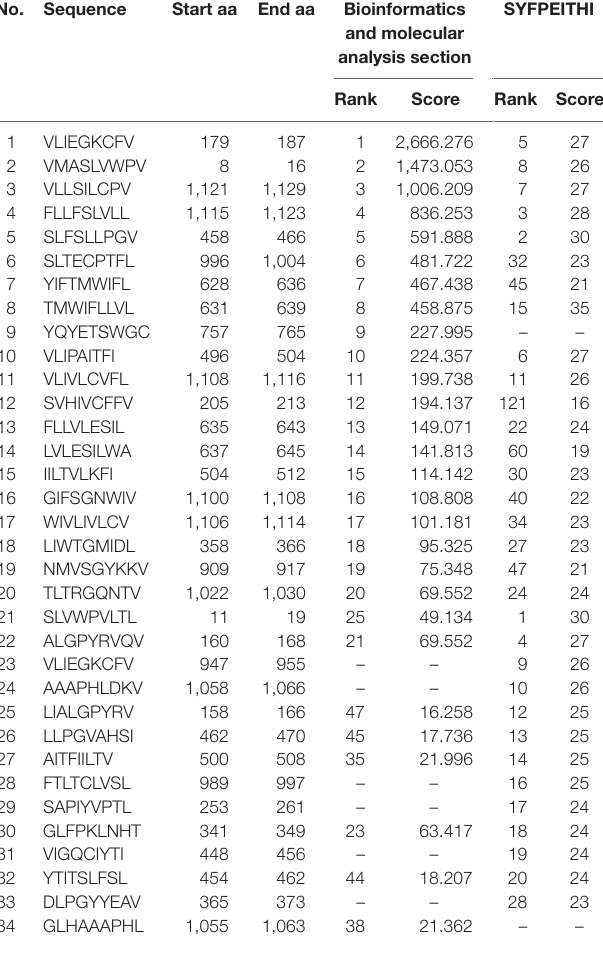
Table 2 | Information for the predicted and synthesized 34 Hantaan virus (HTNV) glycoprotein (GP)-derived HLA-A*0201-restricted nonapeptides. no.